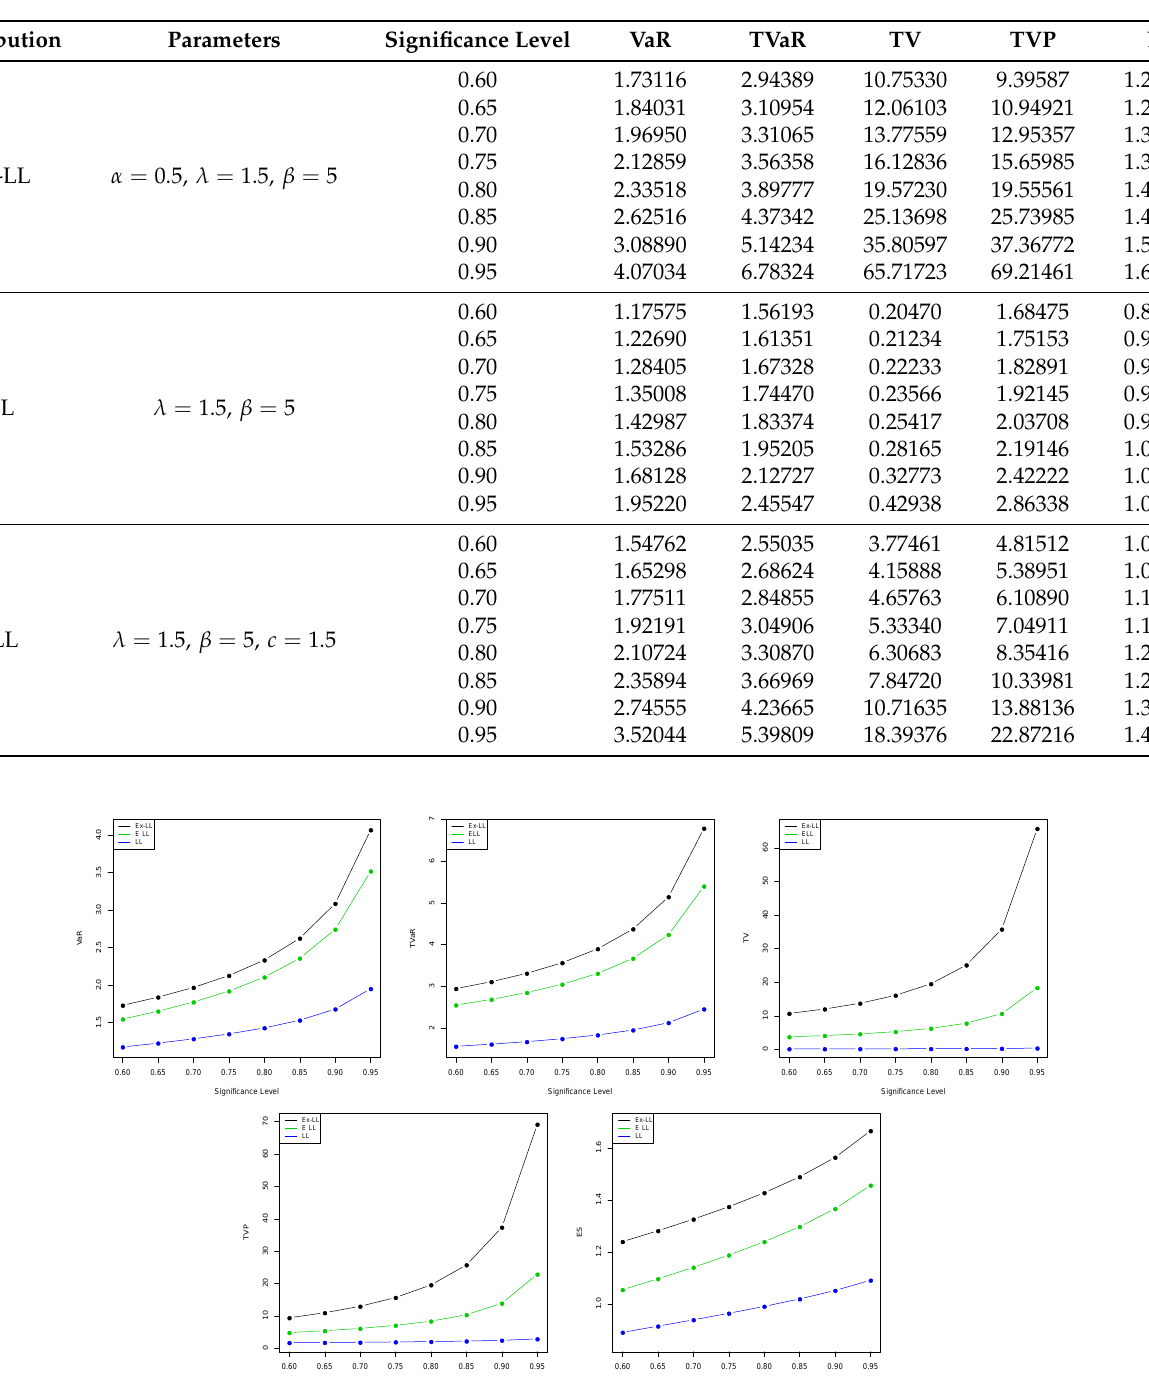
Table 11. Simulation results of the five risk measures for the Ex-LL, ELL, and LL distributions.